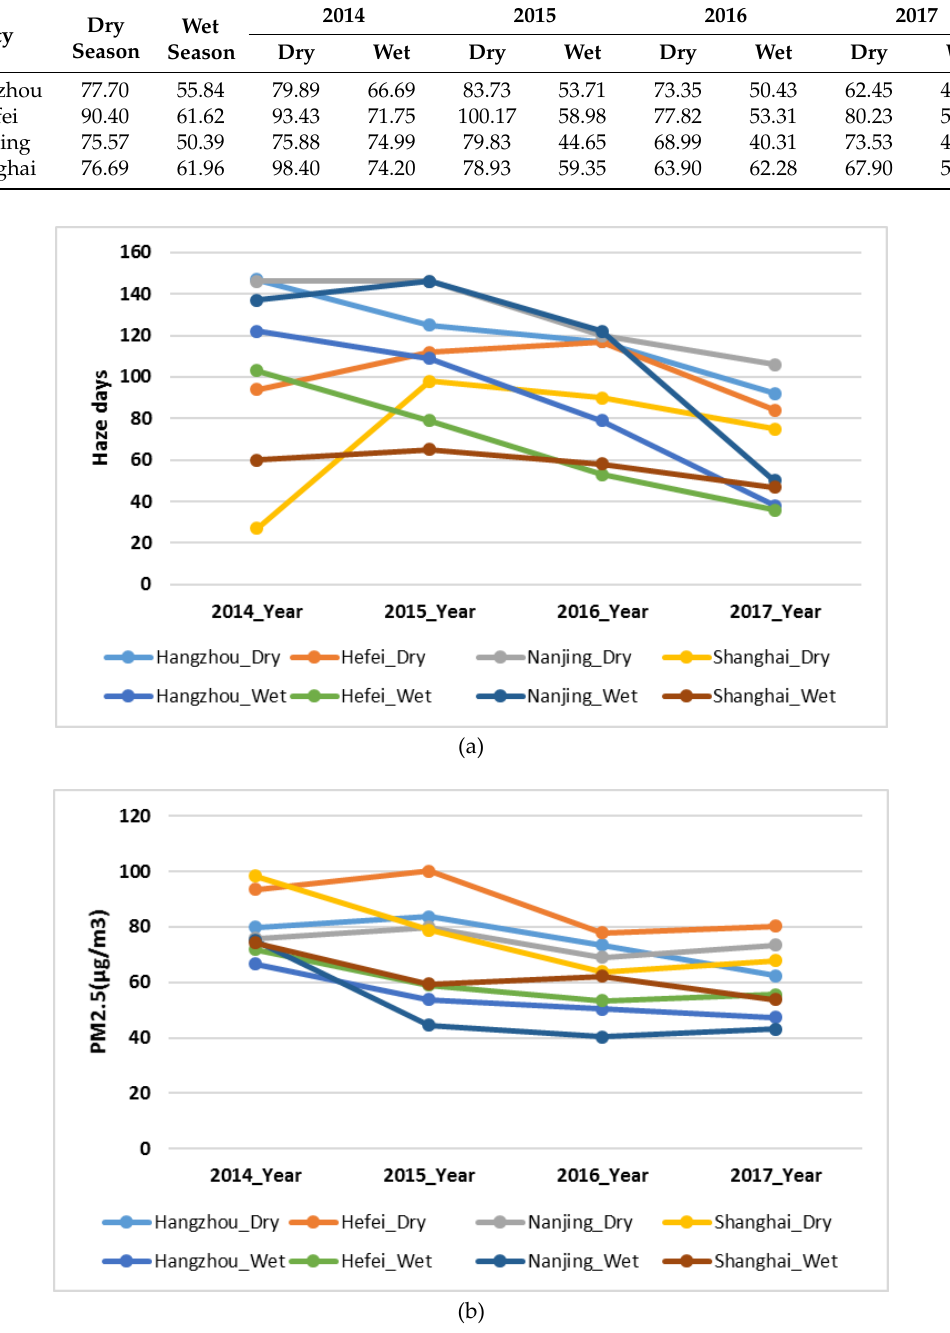
Figure 2. Haze days variety in four major cities ( a ); PM 2.5 variety in four major cities ( b ).